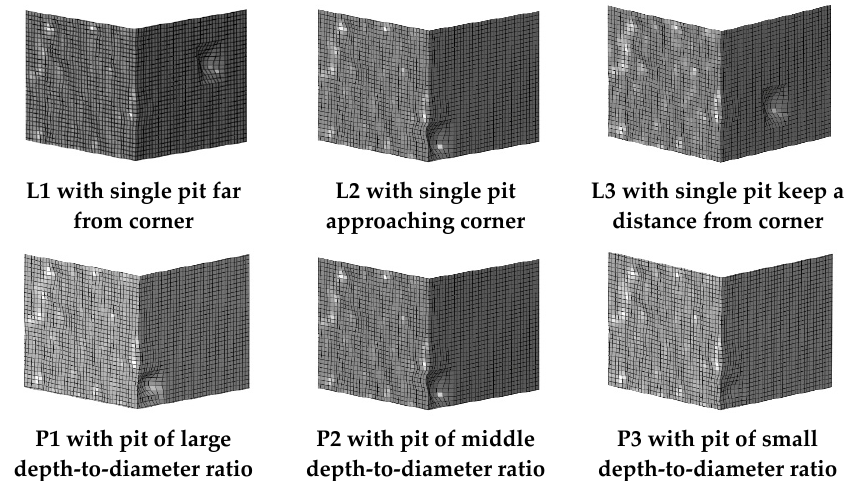
Figure 16. Corner at weld toe with single corrosion pit.